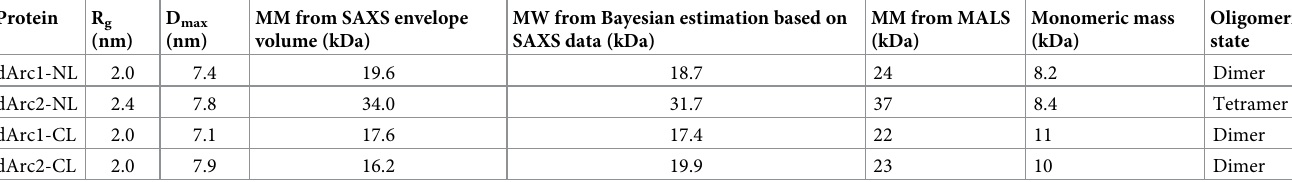
Table 2. Dimensions and oligomeric state for different dArc constructs. Protein R g (nm)